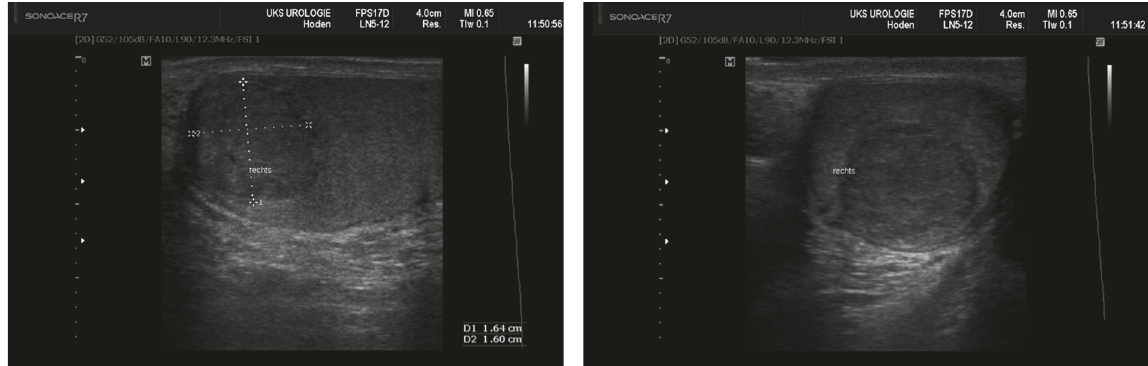
Figure 1: Hypoechogenic tumor in the upper pole of the right testis, measuring 1.6x1.6 cm, shown in sagittal (A) and transversal (B) plane.